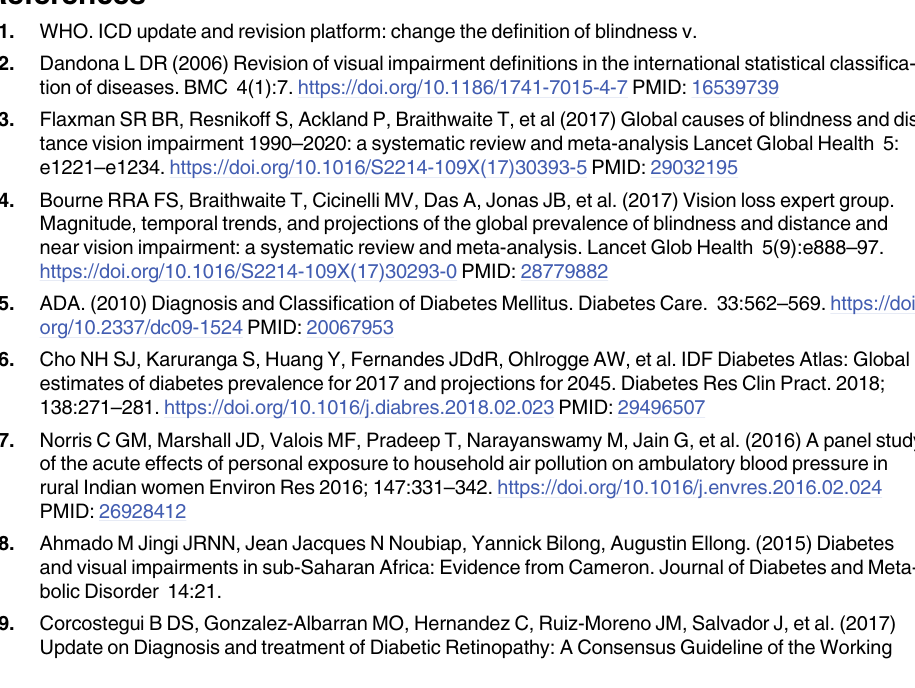
S1 Table. The univariate analysis of visual impairment of diabetic